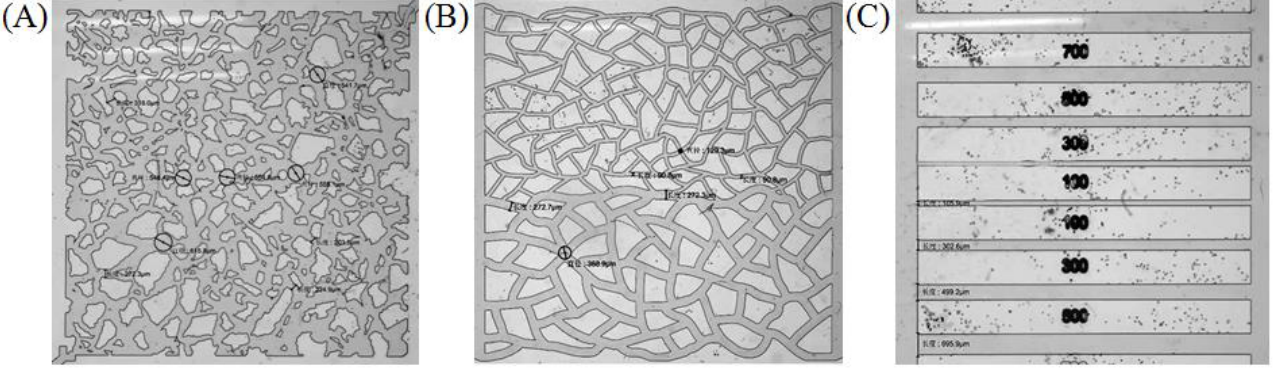
Figure 11. Simulation homogeneous model ( A ), heterogeneous fracture model ( B ) and parallel straight channel model ( C ). Black painting in the images is the corresponding dimensioning.